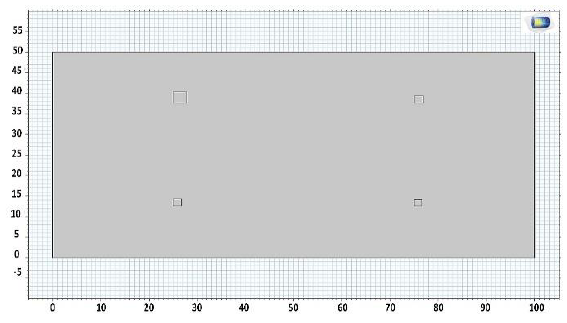
Fig. 2 . Modelling the Altera board with the four critical heat sources.